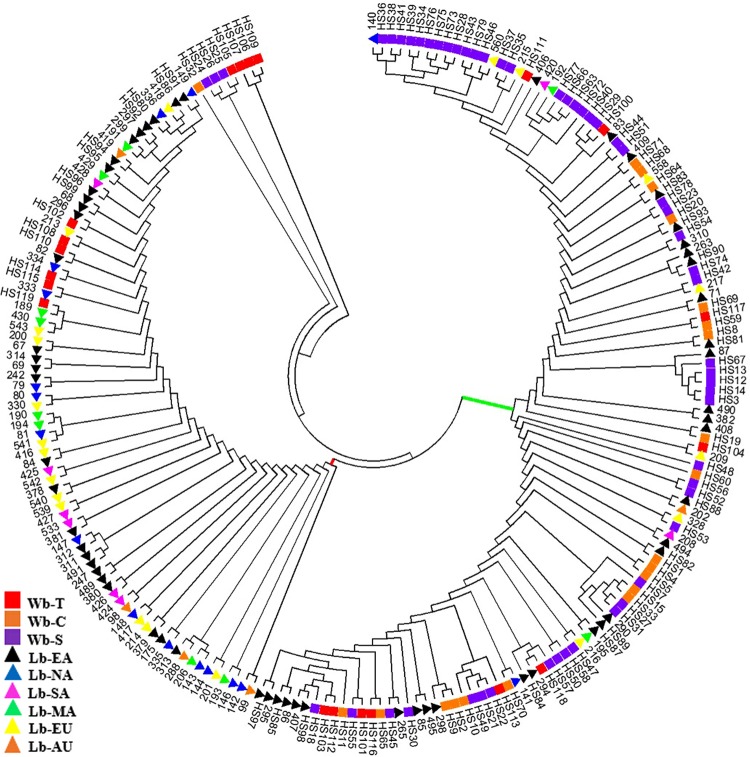
Phylogenetic tree of 214 barley accessions based on the NAM-1 gene. Two major clusters, one comprised of a majority of wild barley accessions (represented in green bar) and another comprised of a majority of cultivated barley accessions (represented in red bar) are separated. The square stands for wild barley accessions: Tibet (Wb-T, red), Southwest Asia (Wb-S, purple), and Central Asia (Wb-C, orange), respectively; the triangle indicates landrace barleys: East Asia (Lb-EA, black), North America (Lb-NA, blue), South America (Lb-SA, pink), Mediterranean Coast Areas (Lb-MA, green), Europe (Lb-EU, yellow), and Australia (Lb-AU, orange).